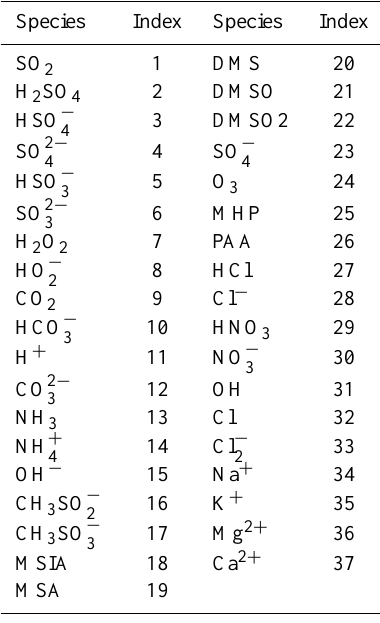
Table A1. Index list for aqueous species included in the revised cloud chemistry module a